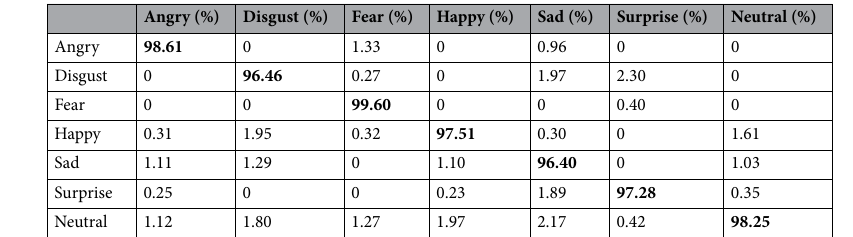
Table 5. Confusion matrix of 7 class facial emotion recognition results obtained by ConvNet with LBP on the CK+ dataset. Significant values are in